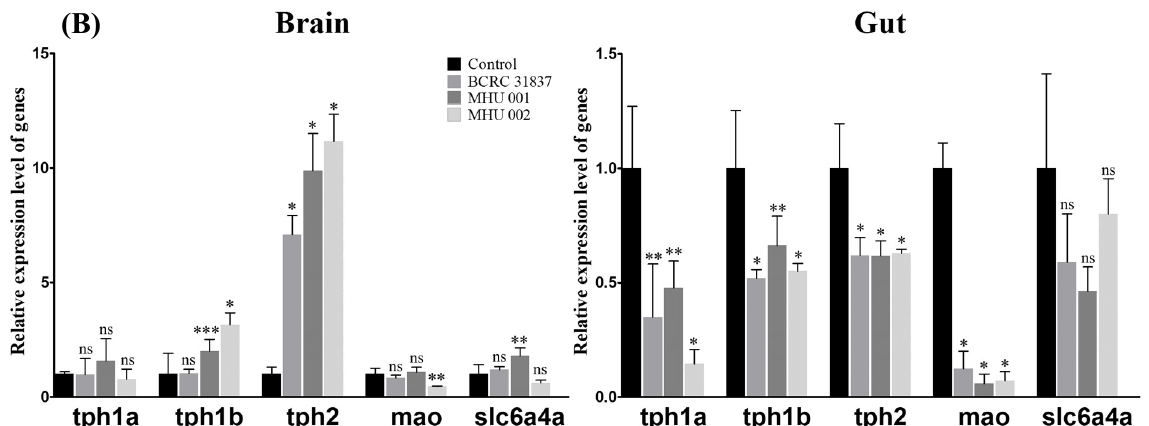
Figure 6. Tempeh feeding induces changes in neural gene expression in zebrafish brain and gut. Controls fed a normal diet. Relative expression of D. rerio bdnf ( A ) and tph1a , tph1b , tph2 , htr1aa , slc6a4a , and mao ( B ) genes in brain and gut of zebrafish treated with tempeh fermented with different strains of R. oryzae , i.e., BCRC 31837, unknown MHU 001, unknown MHU 002, and a control group receiving normal feed. The mean relative expression levels of the tempeh group were normalized to the mean relative expression of the control group. AU, arbitrary units. Bars represent SEM. The asterisks indicate statistically significant differences between the control and the tempeh groups. Bars, means of triplicates ± S.D. (*) p < 0.001, (**) p < 0.01, (***) p < 0.05, (ns) p > 0.05, as compared with the relative control group by one-way ANOVA (A) and two-way ANOVA (B), respectively; ns indicates non-significant differences.